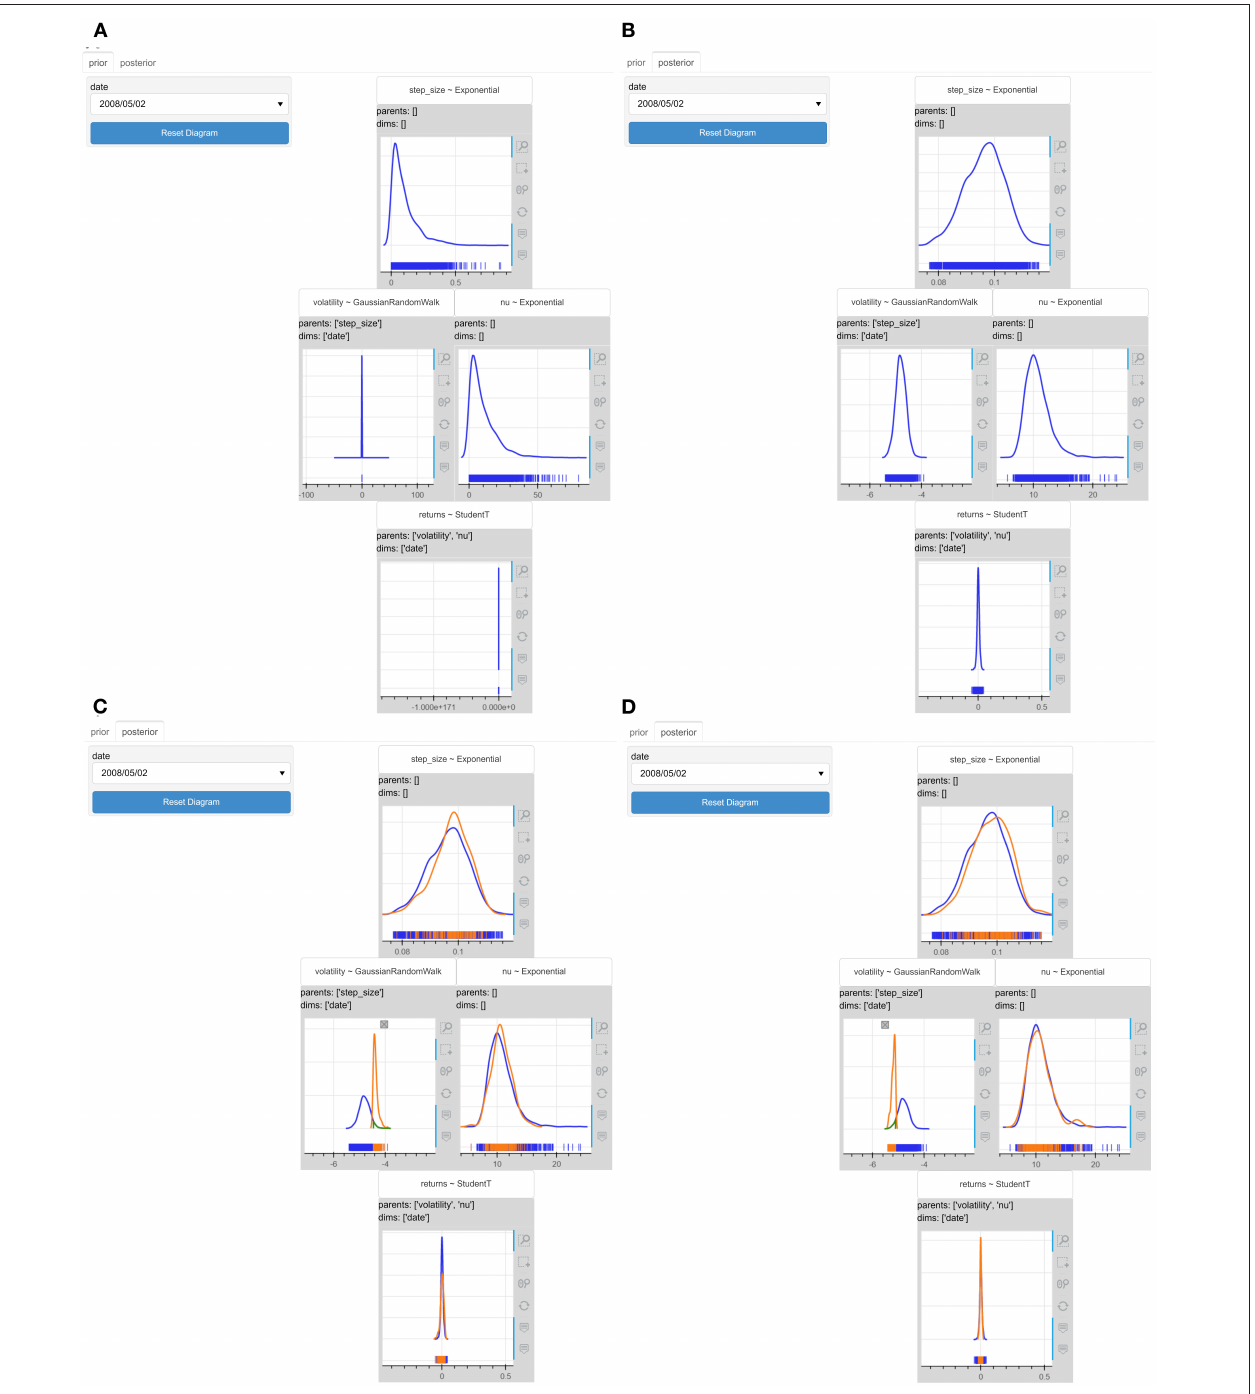
FIGURE 10 | The interactive probabilistic models explorer of the stochastic volatility model. PyMC3 was used for the models’ specification and inference. (A) The prior graphical representation. (B) The posterior graphical representation. (C) The updated posterior graphical representation after restricting the volatility to values greater than − 4.5. (D) The updated posterior graphical representation after restricting the volatility to values smaller than − 5.1. The greater the value of the volatility, the more uncertain the model becomes about the predicted values of the returns.